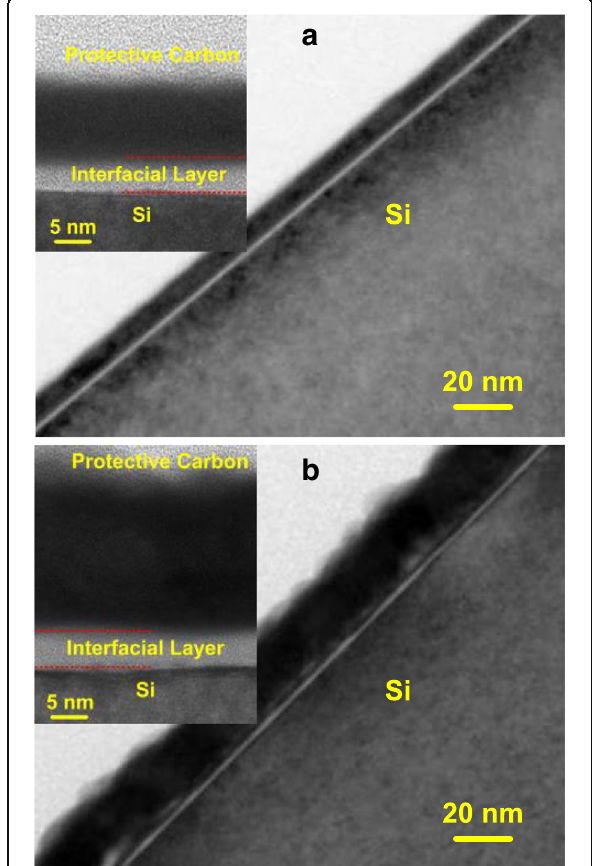
Fig. 6 HRTEM images for the annealed La 2 O 3 films after being exposed to air for 48 h. a 10 nm La 2 O 3 film annealed at 600 °C and b 20 nm La 2 O 3 film annealed at 600